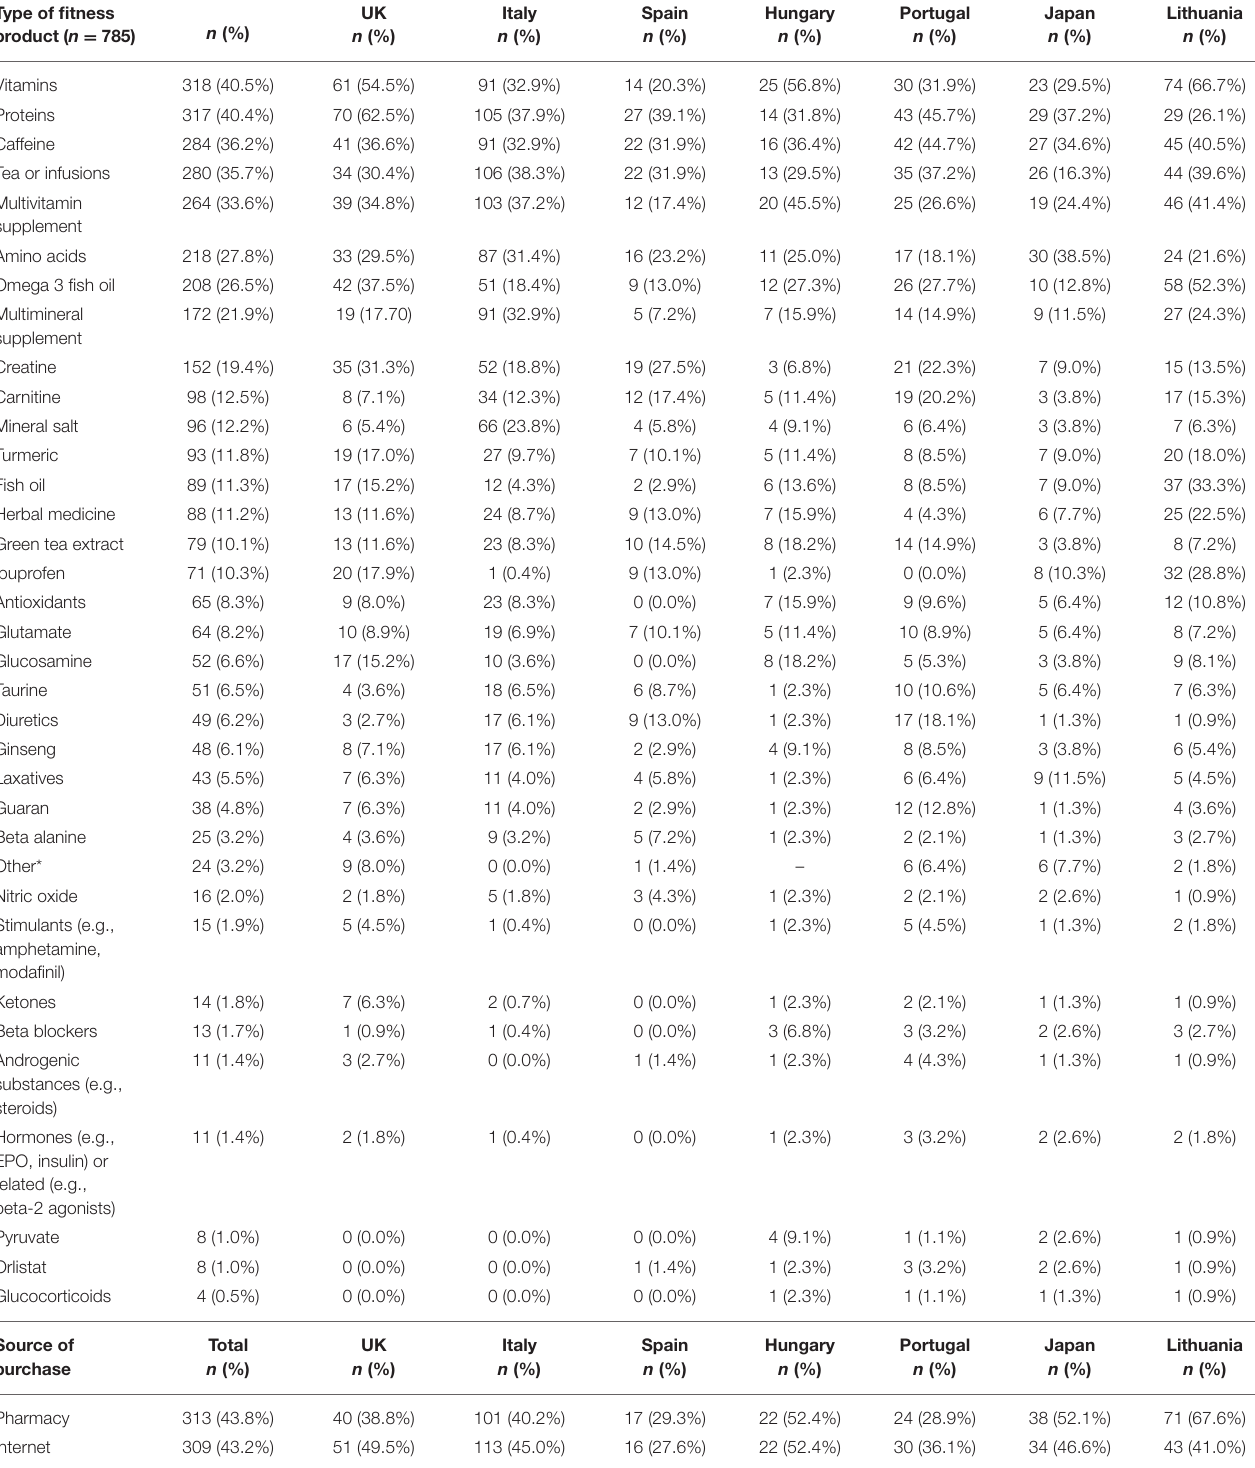
TABLE 4 | Use of fitness supplements: type and source of purchase (total and by